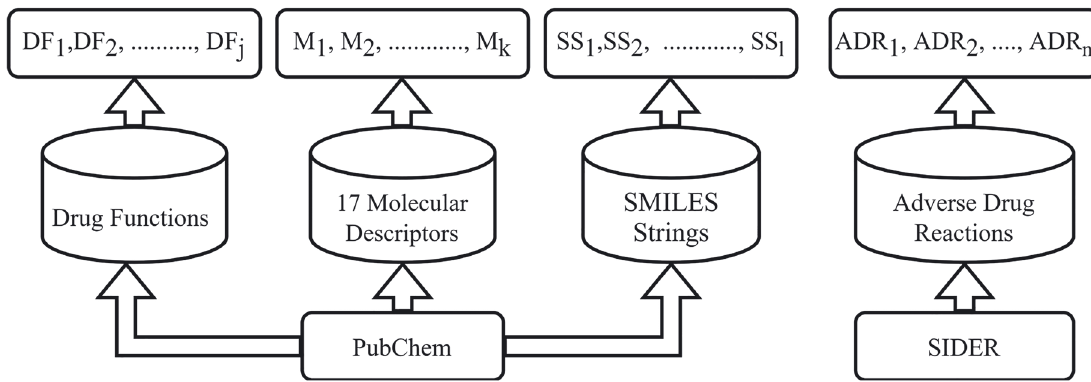
Figure 3: Extraction of data related to drug properties, drug functions and ADRs.